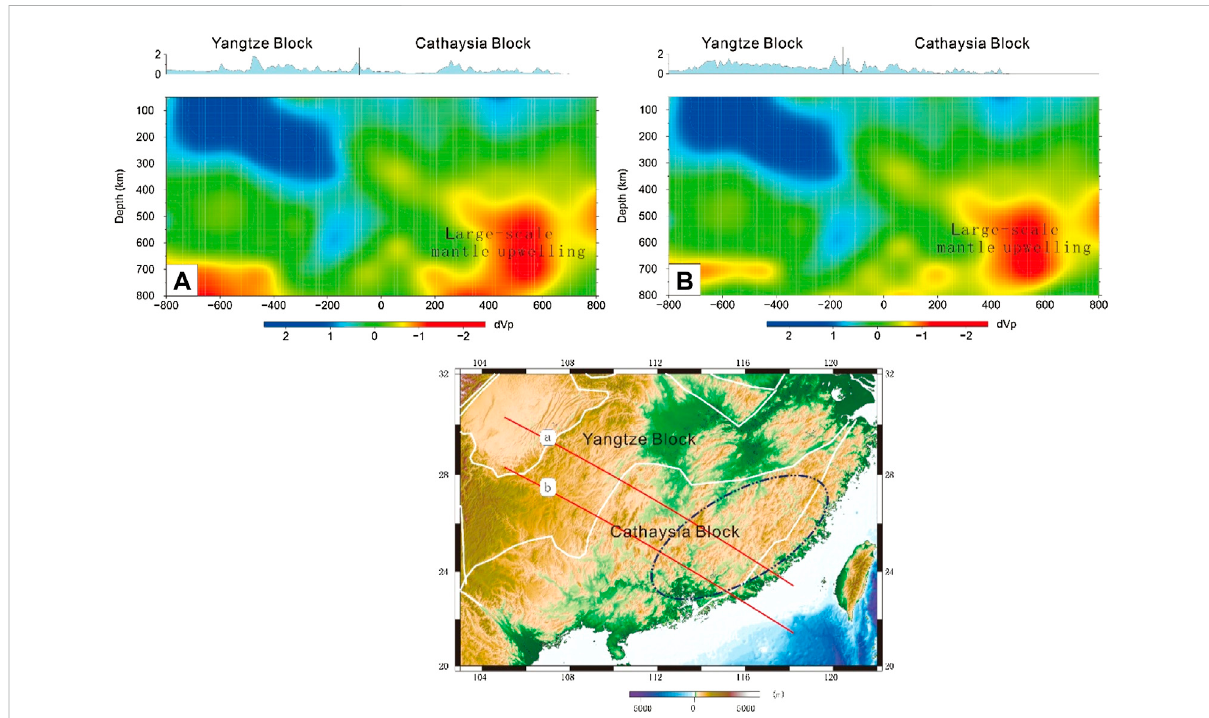
FIGURE 7 P-wave velocity perturbations (He and Santosh, 2016). Large-scale mantle upwelling beneath the Cathaysia Block. Blue oval: the location of large-scale mantle upwelling. Horizontal ordinate (A,B) :